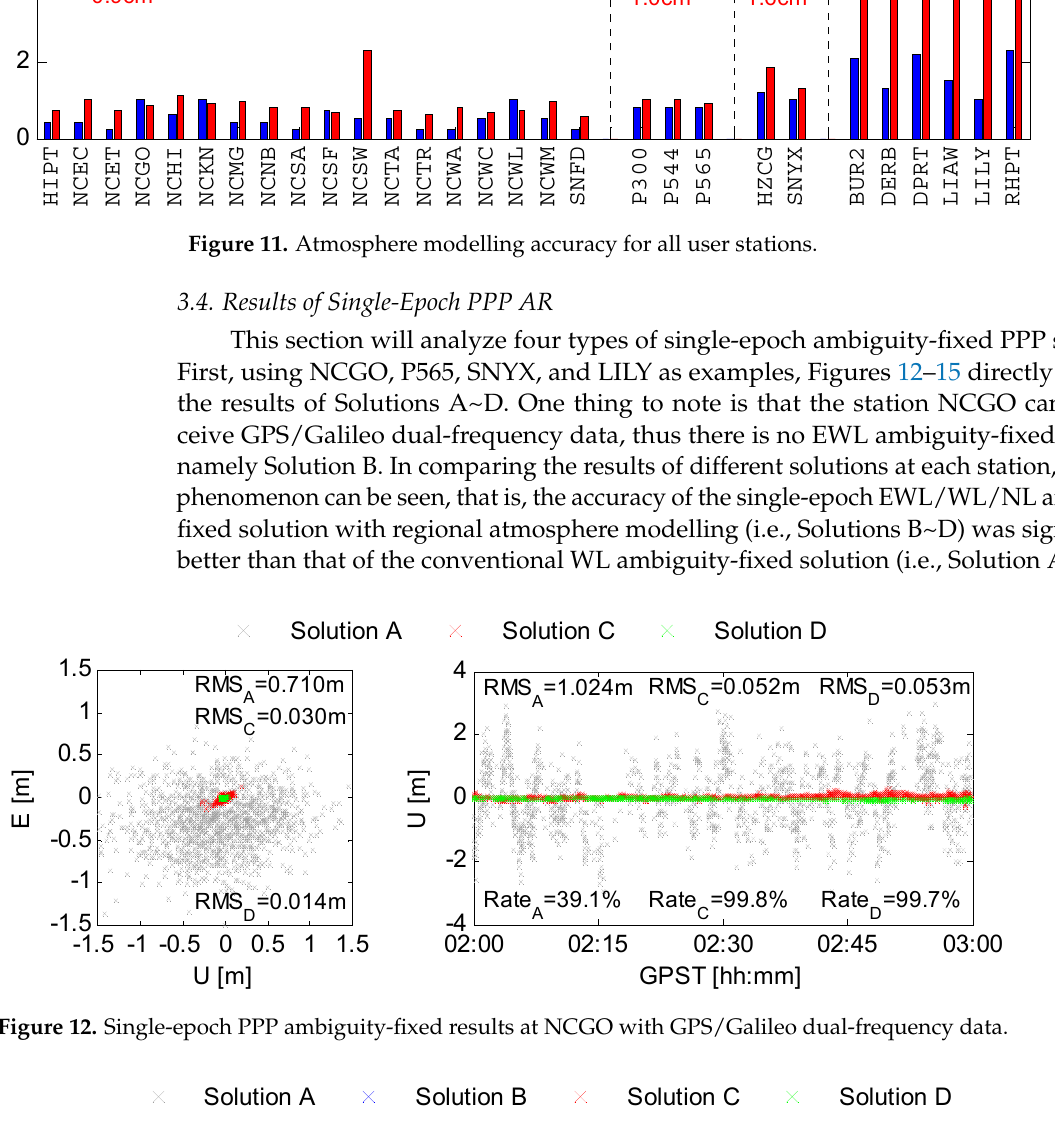
1.5-1.5 -1.5 -1 -0.5 0 0.5 1